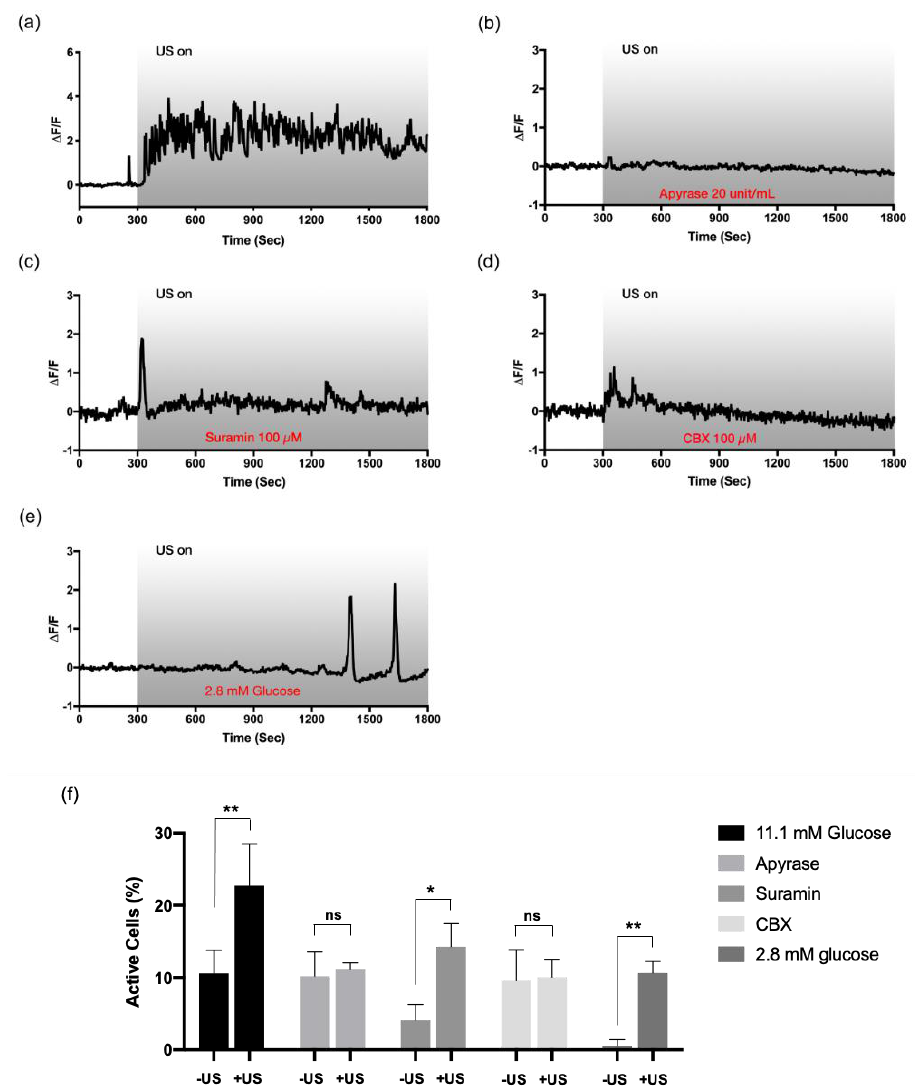
Figure 3. Involvement of purinergic signaling and hemichannels in the ultrasound-evoked Ca 2+ mobilization. The HIT-T15 cells pre-incubated (a) without inhibitor (control) or with ( b ) apyrase (degrades extracellular ATP, 20 unit/mL), ( c ) suramin (P 2 receptor inhibitor, 100 µM), and ( d ) carbenoxolone (CBX) (hemichannel inhibitor, 100 µM) were stimulated by ultrasound to investigate the underlying pathway. In all cases, ultrasound-induced Ca 2+ dynamics were abolished, indicating the involvement of purinergic receptors triggered by ATP released from hemichannels. All experiments were carried out with modified HBSS+ containing 11.1 mM glucose except ( e ) where HBSS+ with 2.8 mM glucose was used. Delayed Ca 2+ oscillations were monitored when the cells were adapted to low glucose. ( f ) Percentage of cells showing Ca 2+ dynamics before and after ultrasound stimulation. Only groups pretreated with suramin and 2.8 mM glucose showed statistically significant increases upon ultrasound, yet they were either single peaks (suramin) or delayed oscillations (low glucose). * and ** indicate p -values less than 0.05 and 0.01, respectively. n = 3 for all groups. 3.4. Fast and Irregular Oscillation Depends on P 2 X Receptors Coupled to L-Type Ca 2+ Channels